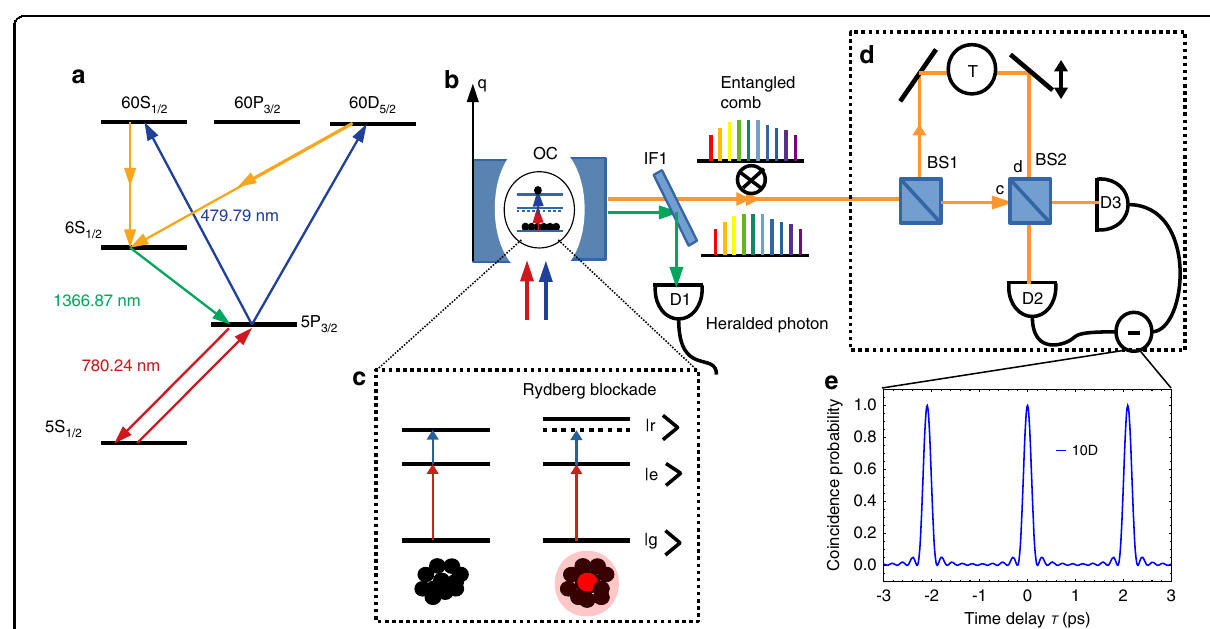
Fig. 1 Schematics for the generation of heralded hyper-entanglement photon pairs. Schematics for the generation of heralded hyper- entanglement photon pairs. a The atom is optically pumped into a Rydberg state with probe beam (red) and the control laser (blue). From the 60S 1/2 (60D 5/2 ) state, due to an optical cavity, the atom decays to 5P 3/2 by emitting an entangled photon pair (yellow) and a heralding photon (green). b The proposed experimental setup where atoms are trapped inside an optical cavity (OC) which is made resonant with the two-photon transitions from 60S 1/2 → 6S 1/2 and the heralding photon. All the dominant fi rst-order transitions are inhibited as they are off-resonant with the cavity resonances. IF: Interference fi lter, D: Single-photon counting module (SPCM), BS: Non-polarizing beam splitter. c A scheme describing the Rydberg blockade. The excitation of even just a single Rydberg atom shifts the energy states of the neighboring atoms, inhibiting further Rydberg excitation within a blockade radius. d Frequency entanglement is detected by measuring the coincidence probability as a function of delay τ , between the paths of the two entangled photon combs. e The coincidence probability for a ten-dimensional entangled photon